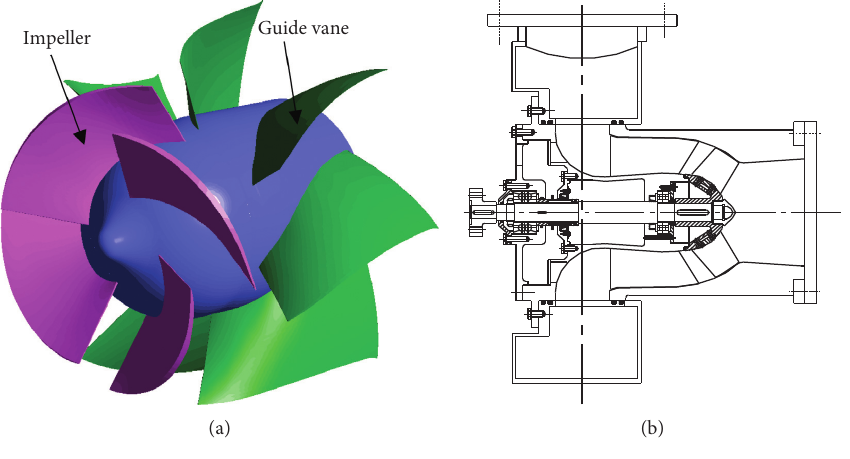
Figure 1: Mixed-flow pump model. Table 1: Parameters of the mixed-flow pump